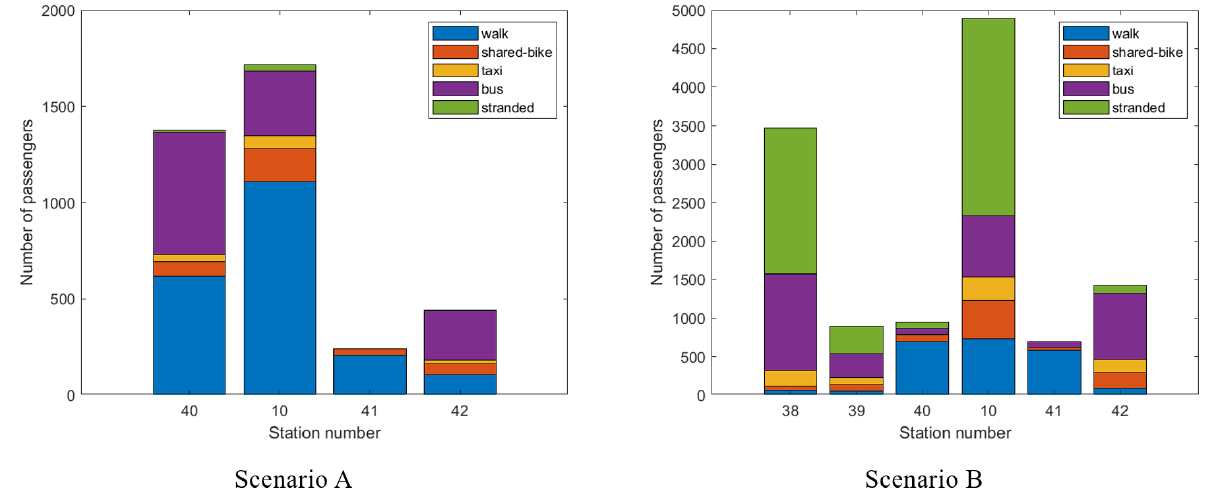
Figure 11. Travel selection results at each interrupted station.